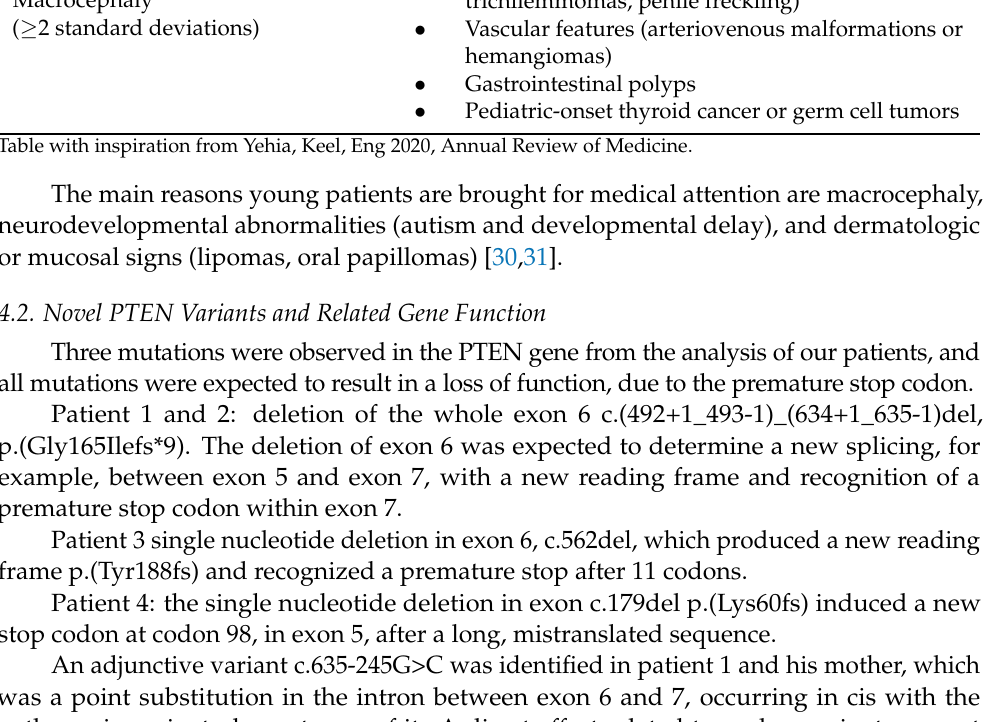
Table 6. Pediatric criteria for diagnosis of PTEN Hamartomas tumor syndrome.